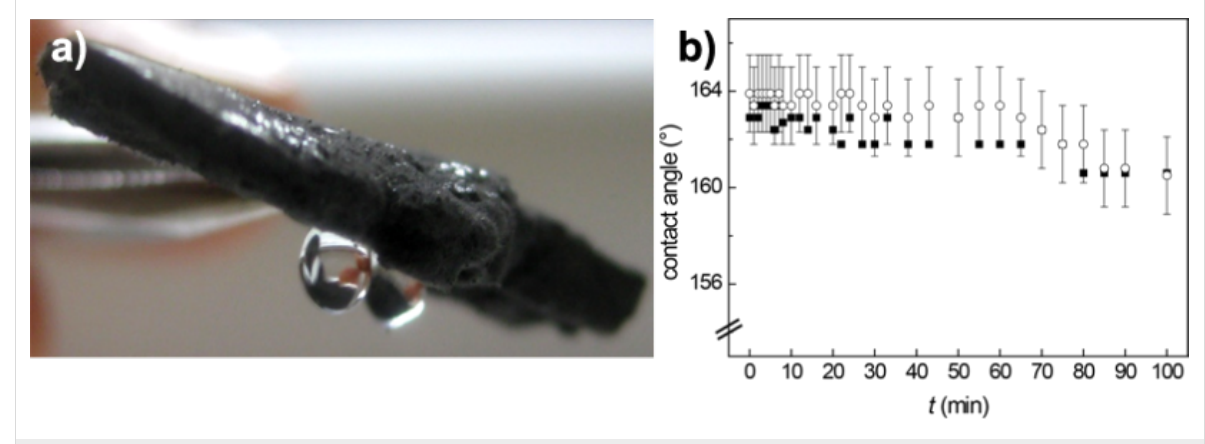
Figure 5: Stability of the super-hydrophobic state. No roll-off angle was measured, even when the substrate is turned upside down (a). Variation of the measured contact angle for a 10 µL water droplet as a function of the time, the vertical scale has been expanded for better view (b).